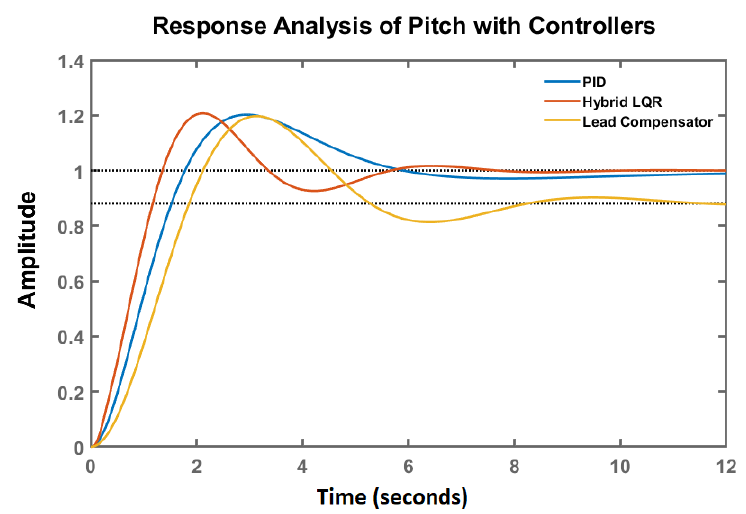
Figure 10. Analysis of pitch control system with controllers.